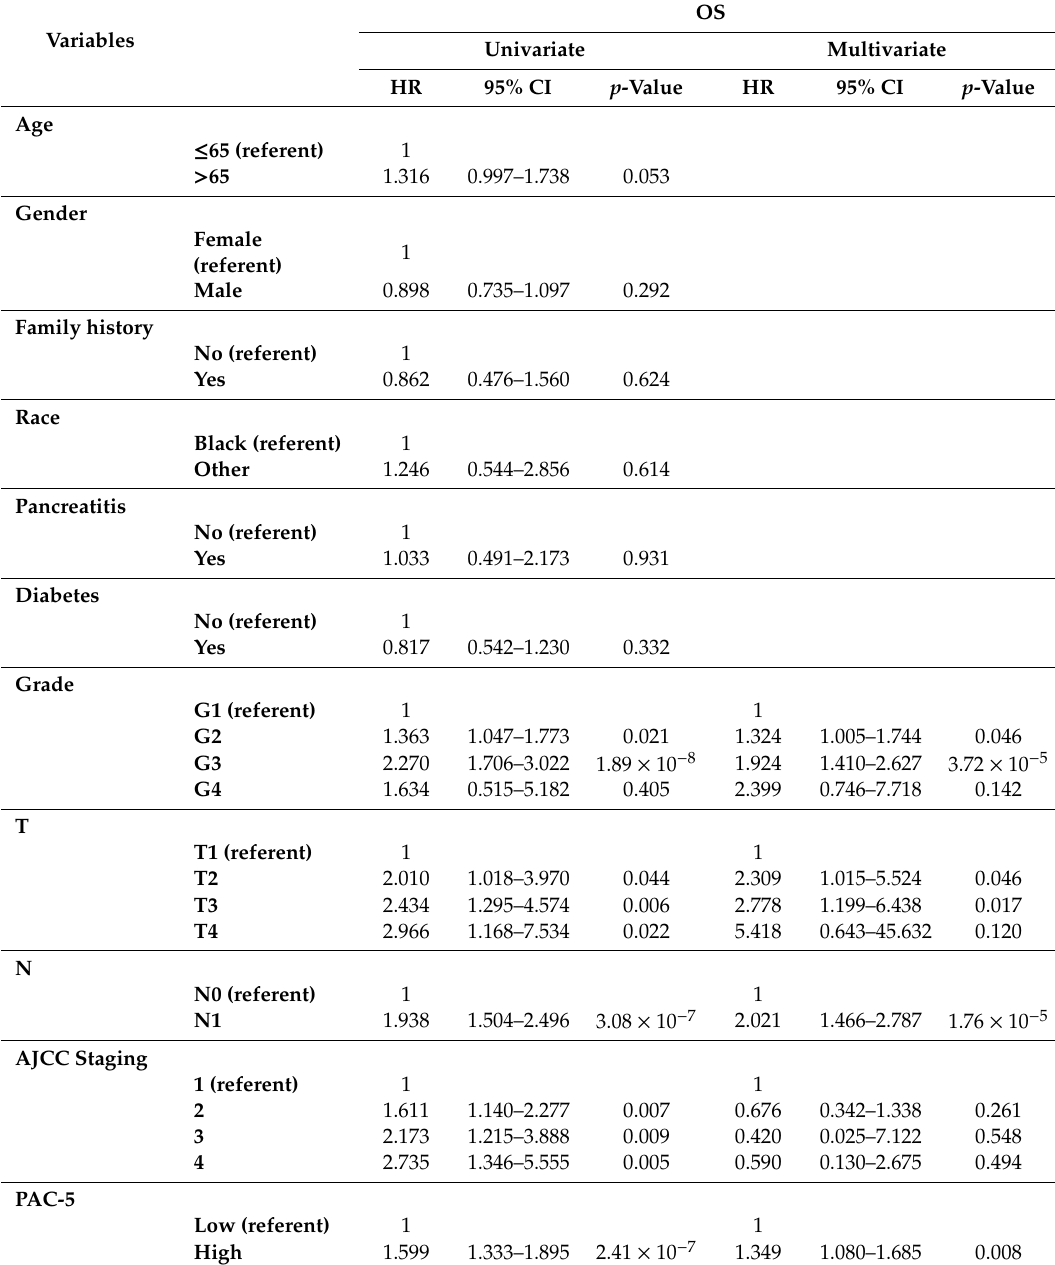
Table 1. Univariate and multivariate Cox proportional hazard regression analyses of clinical variable in validation